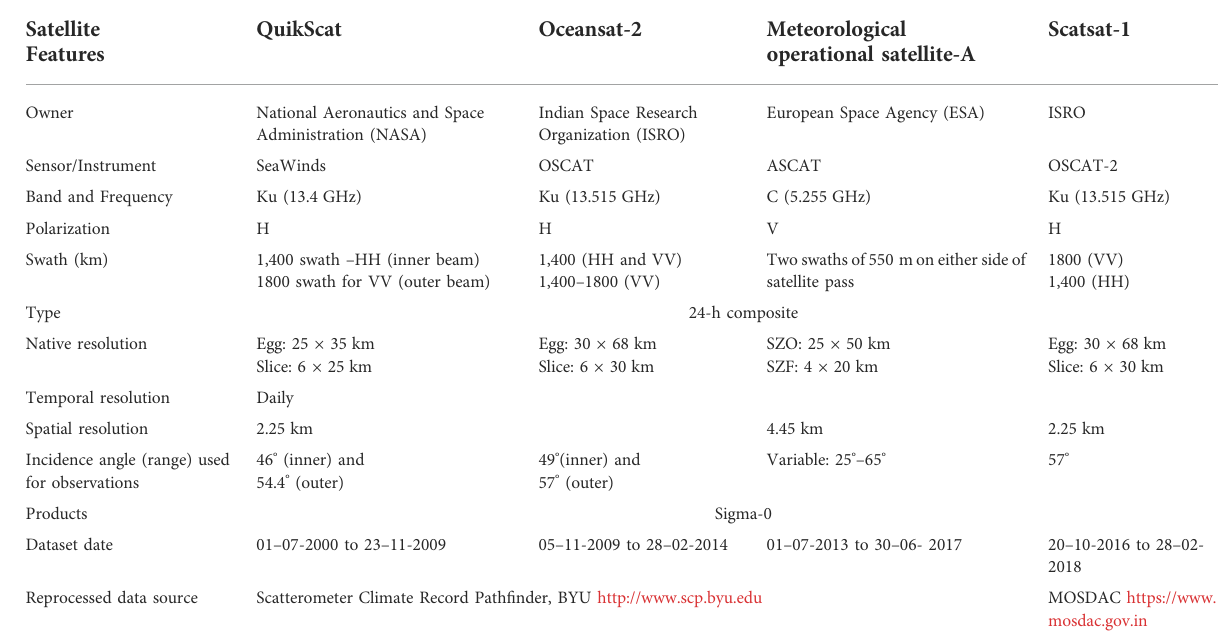
TABLE 1 Data sources and Scatterometer